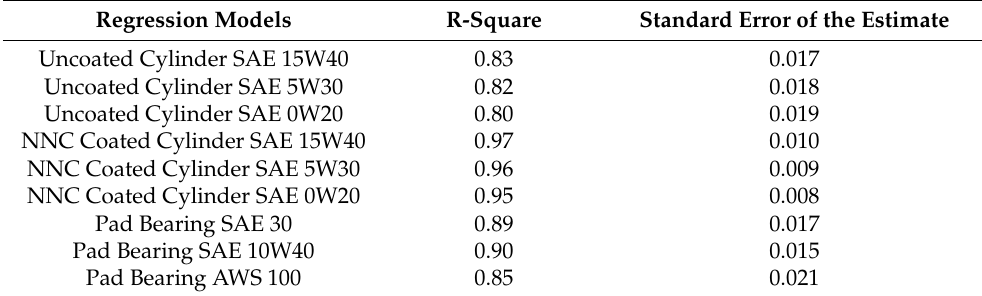
Table 8. Coefficients of determination (R 2 ) and the standard error of the estimate (S) for all the regression